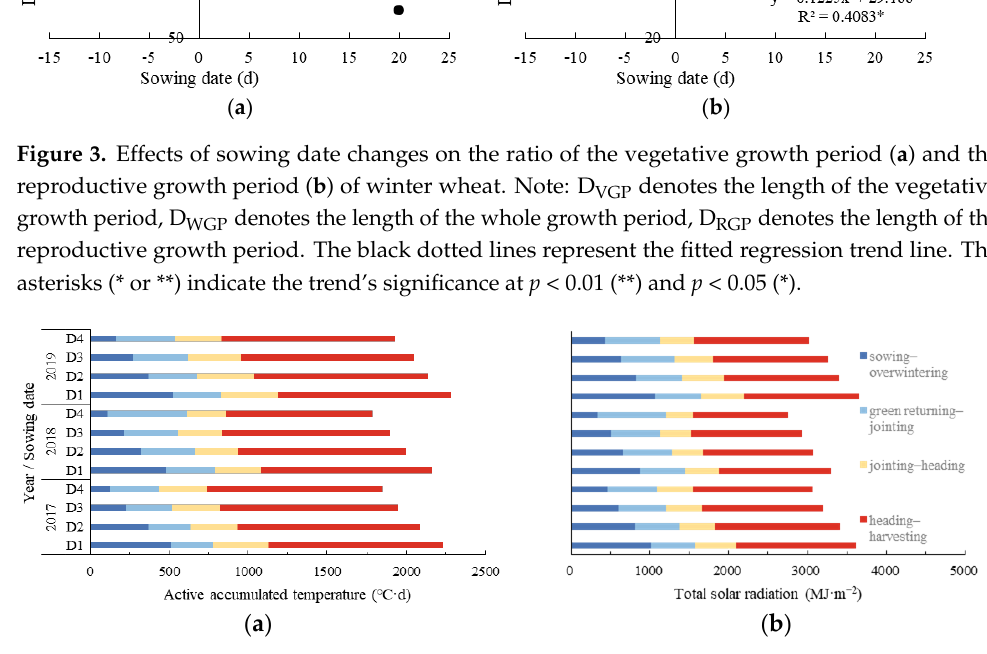
Figure 4. Active accumulated temperature ( a ) and solar radiation ( b ) for different sowing dates of winter wheat at different developmental stages.